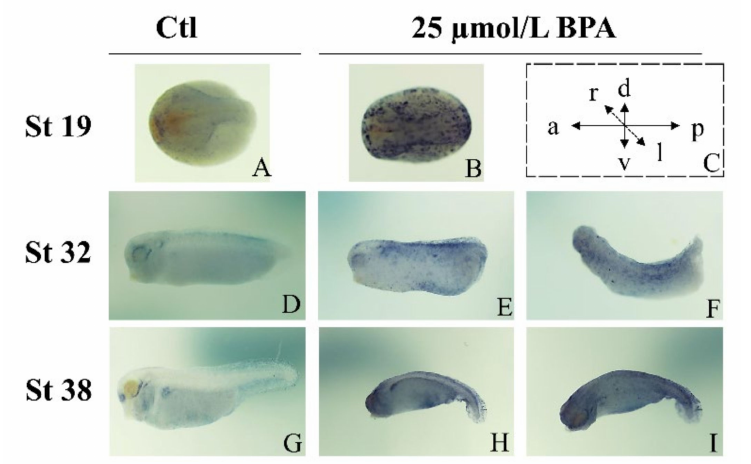
Figure 4. BPA exposure disrupts the spatiotemporal Nrf2 expression patterns during embryonic development, determined using whole-mount in situ hybridizations; representative phenotypes are shown for the control ( A , D , G ) and treated ( B , E , F , H , I ) groups, according to the scheme in ( C ): a, anterior; p, posterior; v, ventral; d, dorsal; r, right; l, left ( C ). n =